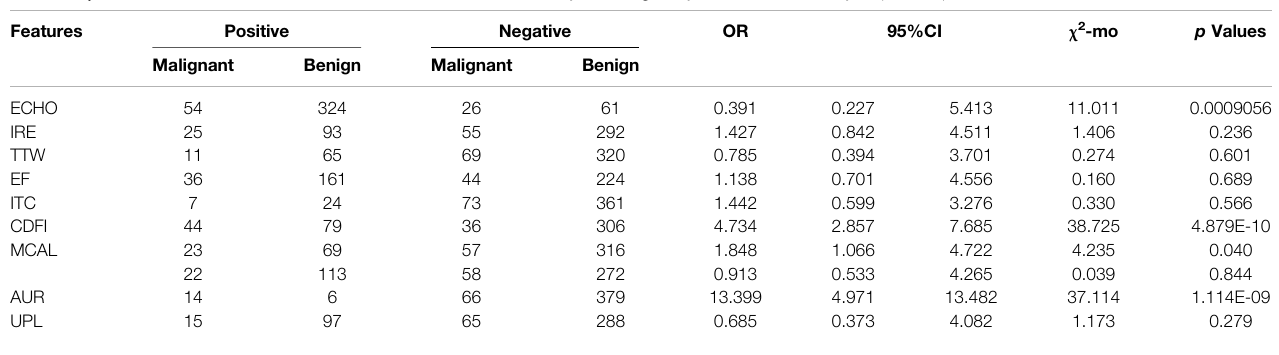
TABLE 2 | Association between ten ultrasound characteristics and FTC thyroid malignancy in the bivariate analysis ( n (cid:1) 465). Features Positive Negative OR 95%CI Malignant Benign Malignant Benign